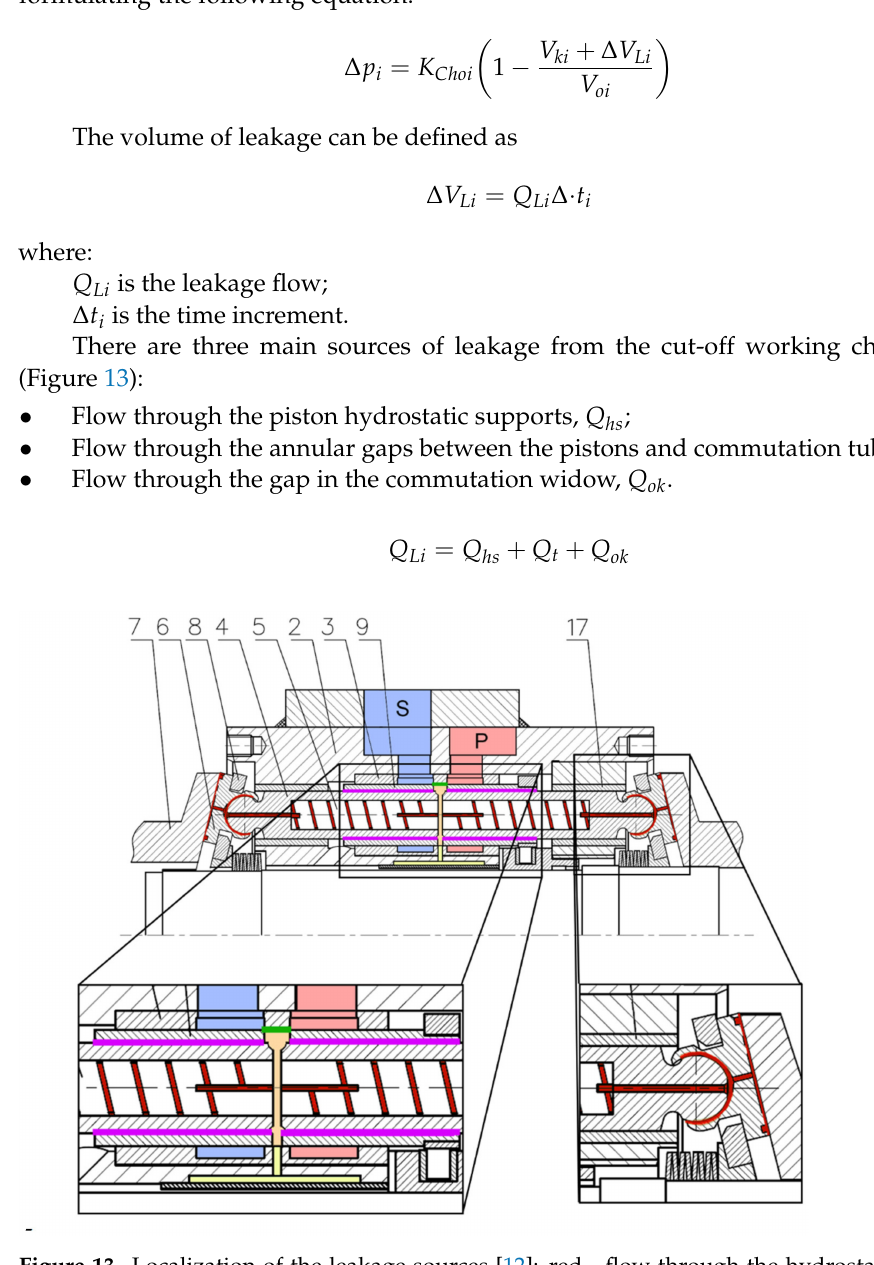
Figure 13. Localization of the leakage sources [12]: red—flow through the hydrostatic supports; purple—flow through the annular gaps between the pistons and commutation tube; green—flow through the gap in the commutation widow; 2—body; 3—socket; 4—piston; 5—spiral choke; 6— slipper; 7—swash-plate; 8—separator plate; 9—commutation tube; 17—guiding